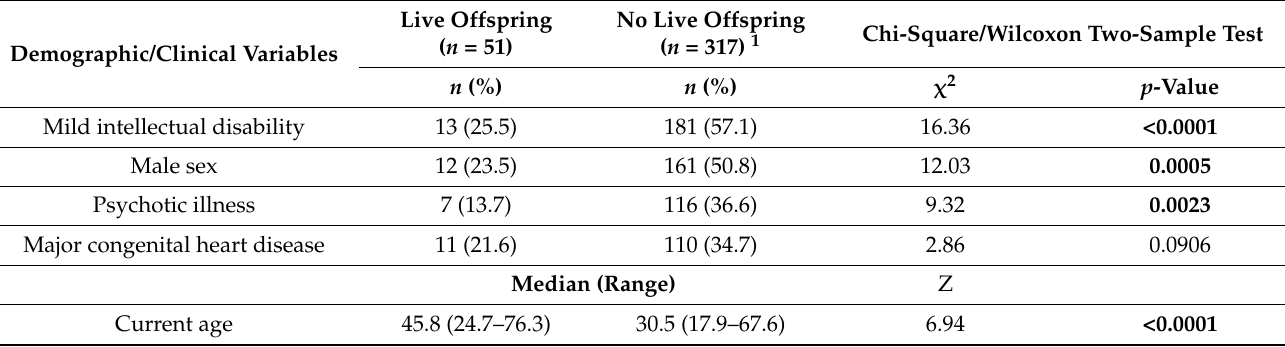
Table 2. Adults with 22q11.2DS ( n = 368) comparing those with ( n = 51) and without ( n = 317) liveborn offspring.